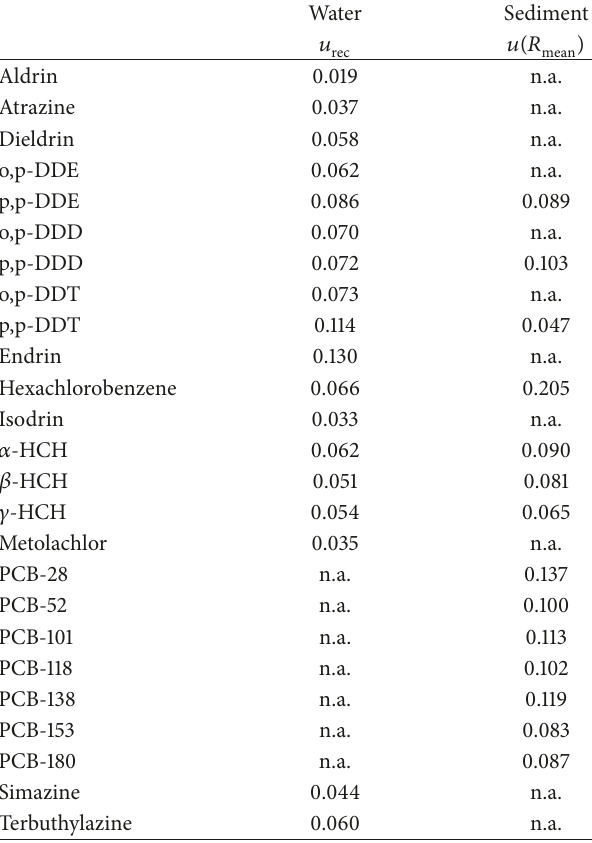
Table 6: Intermediate precision calculated for determination of selected pesticides in water.